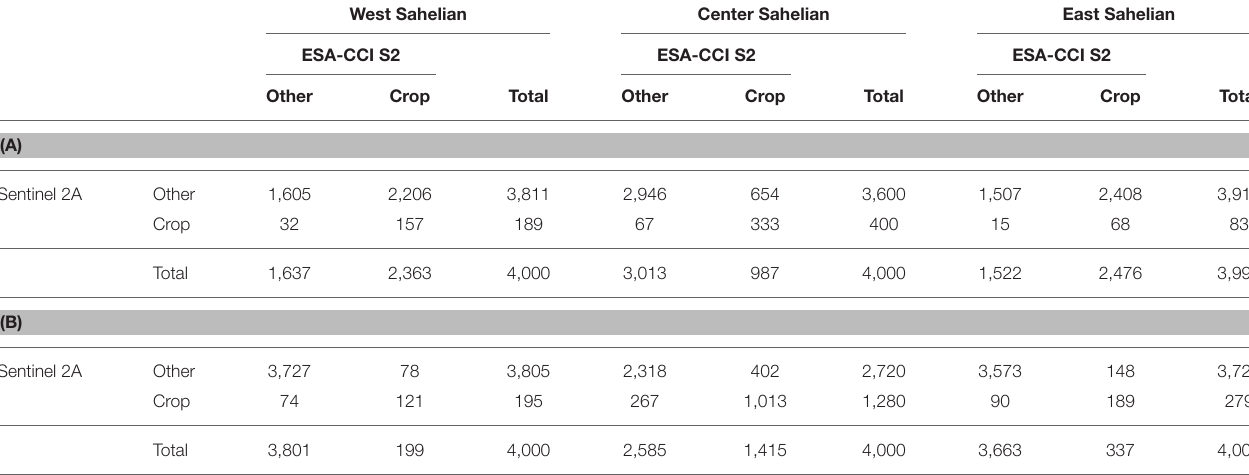
TABLE 4 | Confusion matrices for (A) Sahelian (B) Sudanian sample polygons.